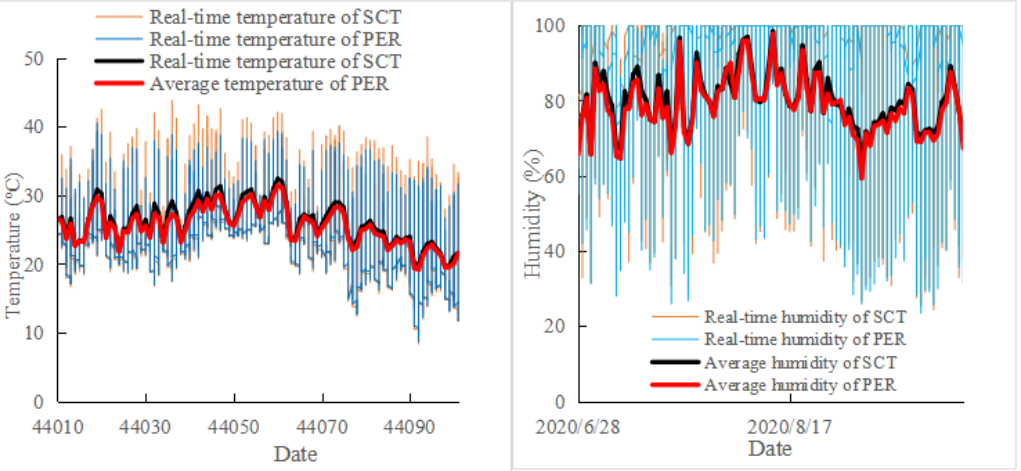
Figure 3. Real-time temperature ( A ) and humidity ( B ) around fruit clusters of PER (pergola) and SCT (single-curtain training system) from July to October.